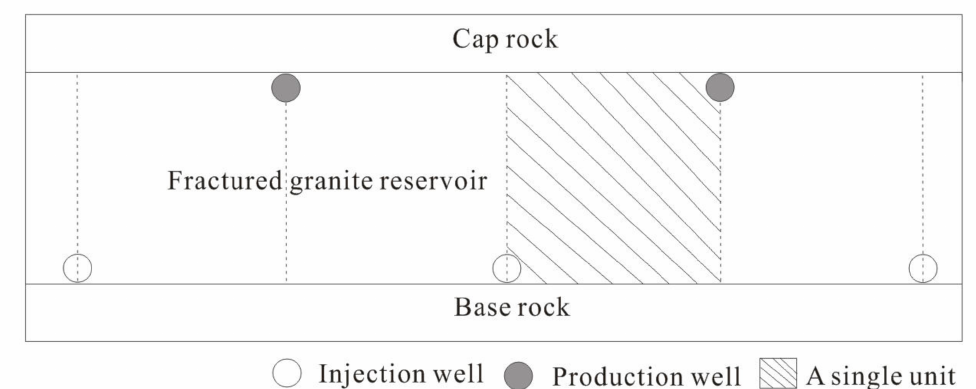
Figure 2. Well arrangement of the 950–1350 m fractured granite reservoir.